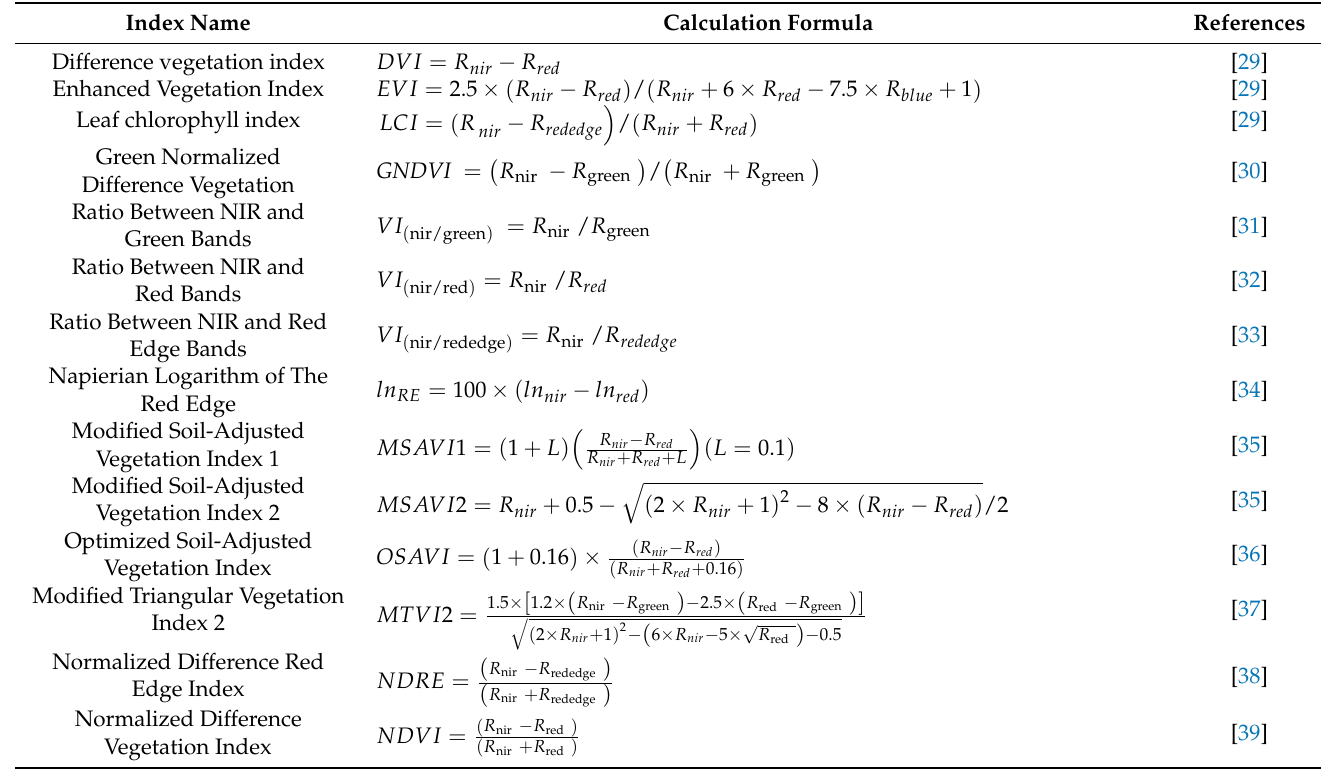
Table 4. Vegetation indices based on MS sing-band reflectance and calculation